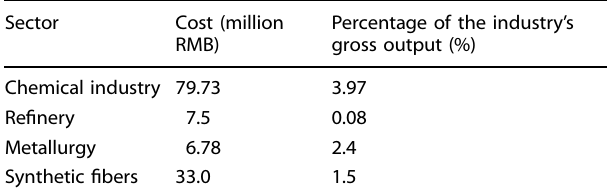
Table 2. The cost of corrosion from a survey conduct by national